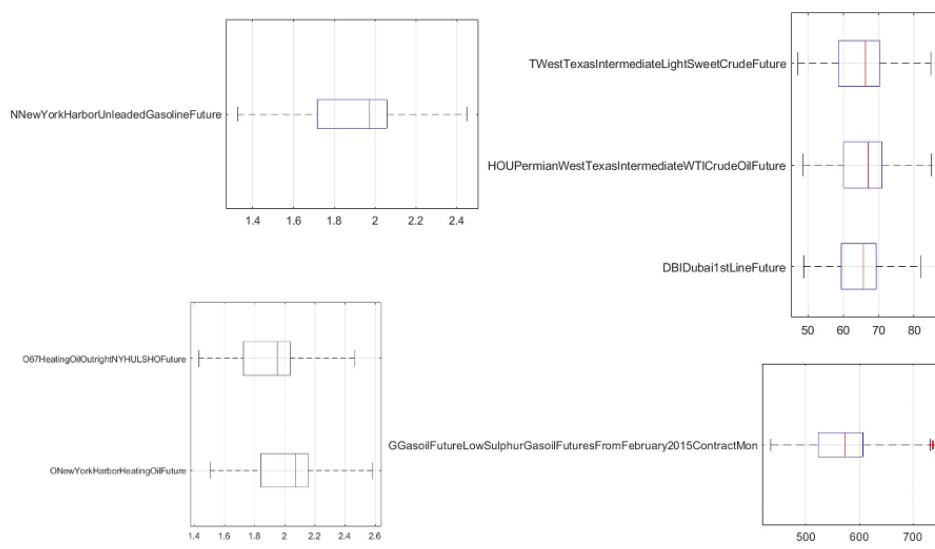
Energies 2022 , 15 , x FOR PEER REVIEW